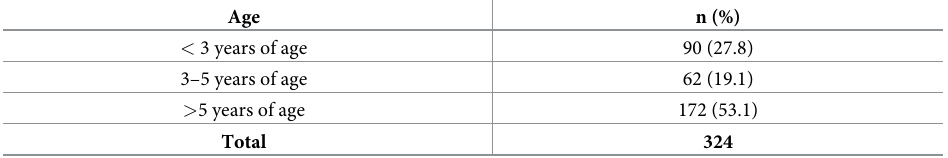
Table 3. The age distribution of DVI with presumed URTI in private